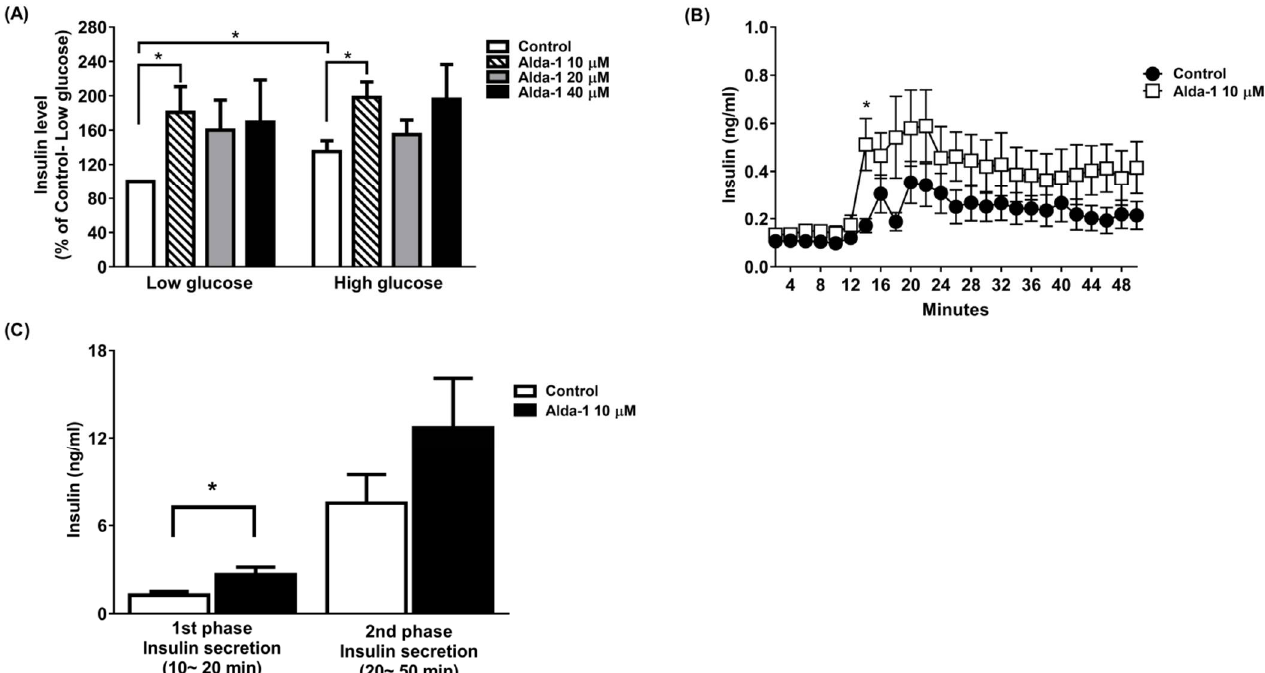
Figure 1. Alda-1 promotes insulin secretion in MIN6 pancreatic beta cells. ( A ) Insulin secretory response in MIN6 cells exposed to different doses of Alda-1 under low (3.3 mM) and high glucose (16.7 mM) concentrations ( n = 3/group). ( B ) Glucose-stimulated insulin secretion in ex vivo perifused islets in the absence and presence of 10 µ M Alda-1. ( C ) First and second phase insulin secretions were measured from the islet perifusion study (details in the Method section). ( n = 14 in the control group, n = 15 in the Alda-1 10 µ M group). Data are presented as mean ± SEM * p < 0.05 versus the control group.